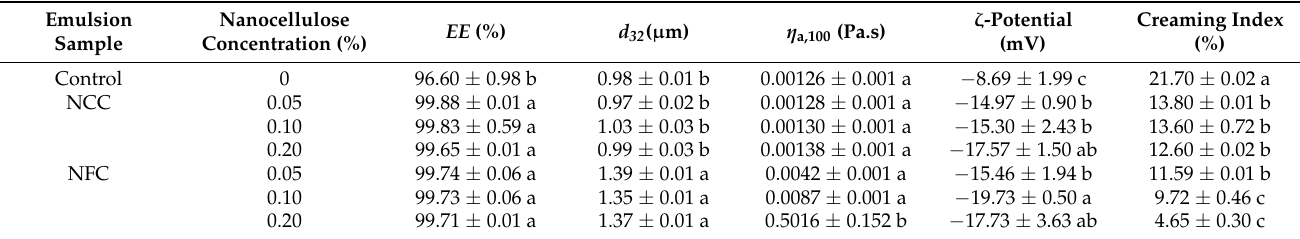
Table 1. Encapsulation efficiency ( EE ), surface-weighted mean particle diameter ( d 32 ), apparent viscosity at shear rate of 100 s − 1 ( η a,100 ), ζ -potential, and creaming index after a storage period of 60 days of the 10% ( w / w ) O/W emulsions containing β -carotene stabilized by NCC or NFC at various concentrations at 0.05, 0.10, and 0.20% ( w / w